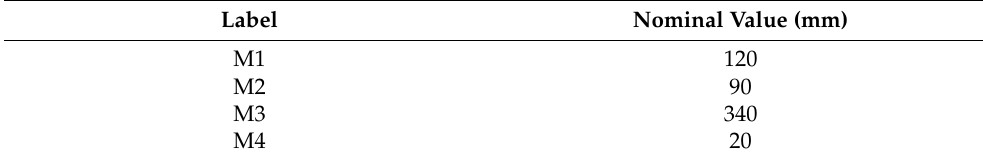
Table 1. Test Sleeve Dimensions.